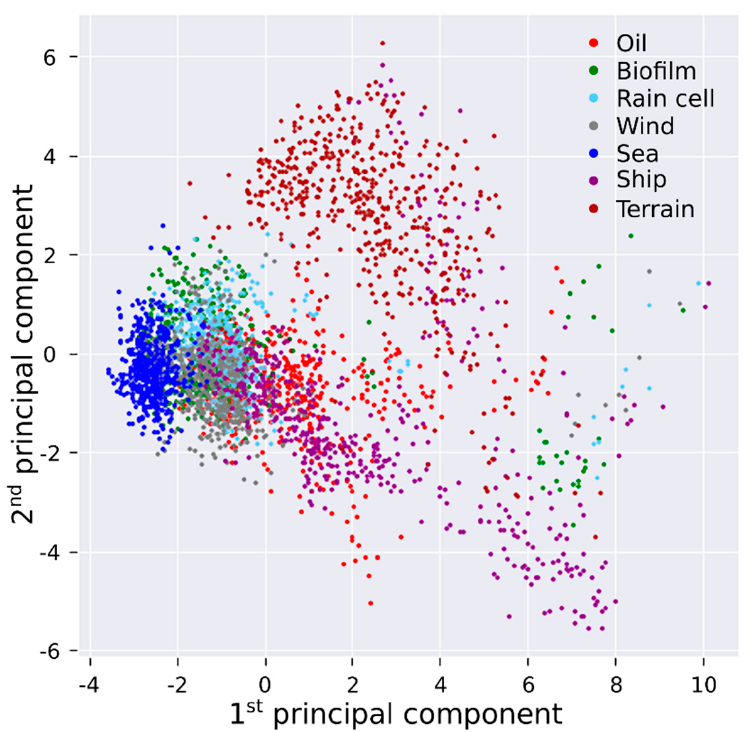
Figure 5. First two principal components’ scatter plot of the dataset, explaining 40% of its variance. Terrain and ocean images form distinct groups throughout the dataset, while oil and its look-alikes share roughly the same class domain.